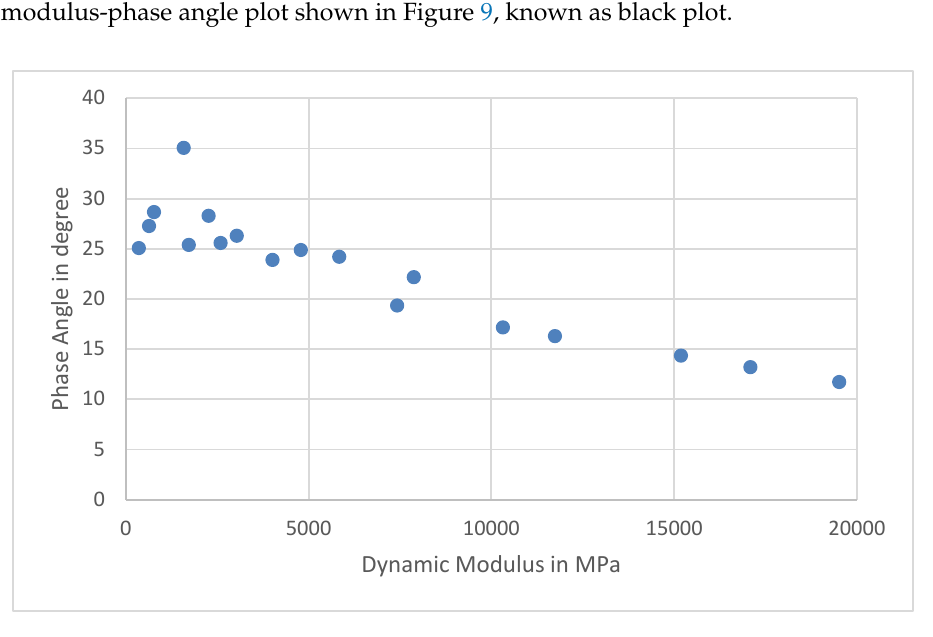
Table 5. Four-point beam fatigue test results and statistical normality tests.